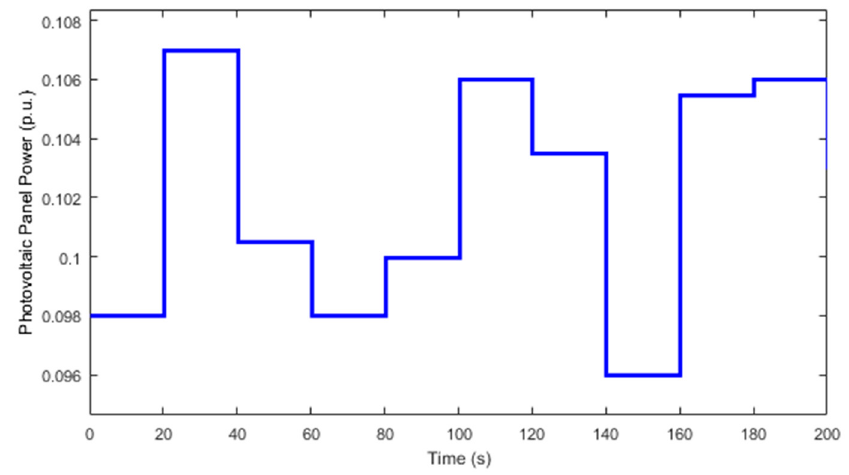
Figure 8. Photovoltaic panel output power.